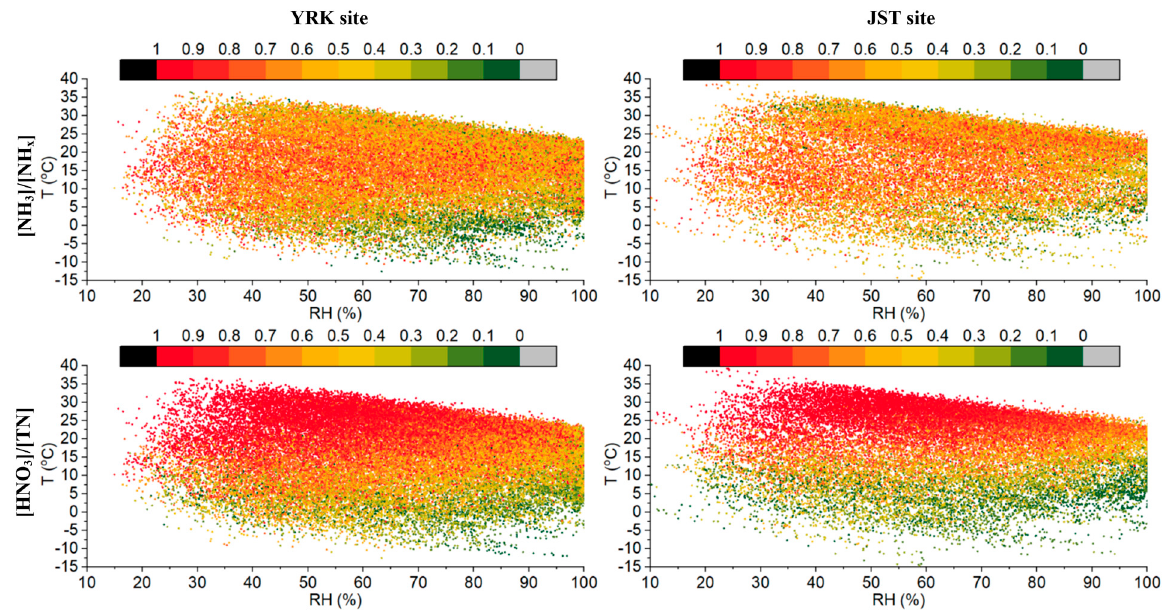
Figure 7. The measured gas-phase NH 3 and HNO 3 molar fractions under different T-RH conditions at the YRK and JST sites.